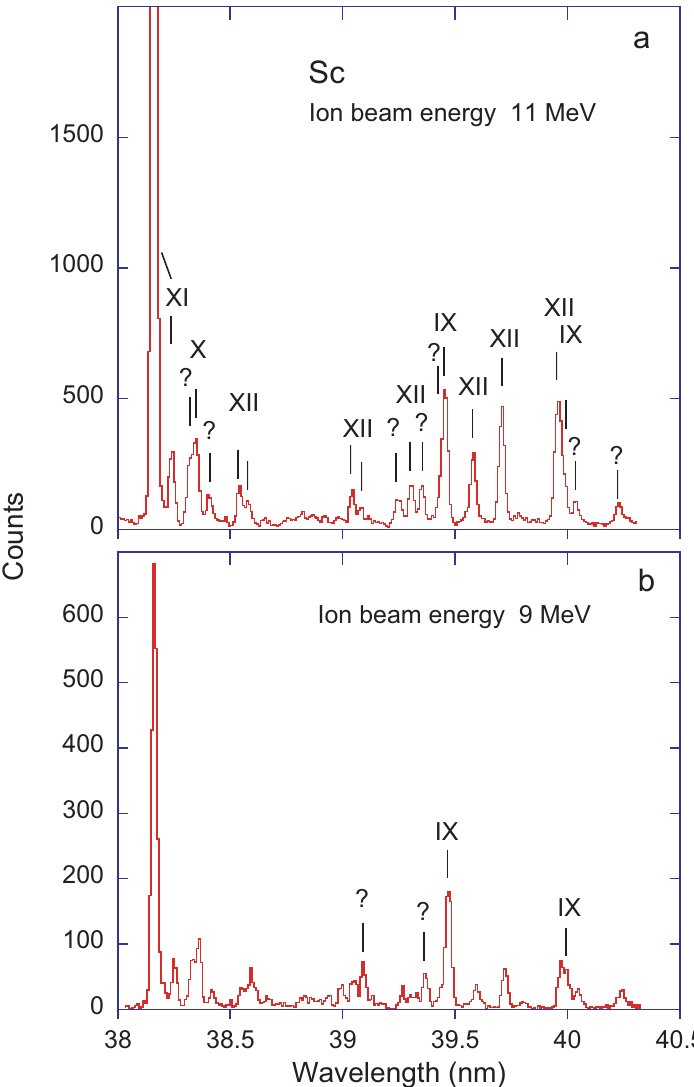
Figure 3. Beam-foil spectra of Sc at an ion beam energy of ( a ) 11MeV and ( b ) 9 MeV. Observation at the foil. Line width (FWHM) 0.03nm. The strongest lines in the upper spectrum are identified by the spectrum number. The lower spectrum indicates the higher yield of ScIX at the lower ion beam energy, while the contributions of ScXII are much weaker. The primary wavelength reference line at λ ≈ 38.1577nm is one of the prominent ScXI 3p–3d transitions which is boosted by yrast cascades. The lines in the wavelength interval 27.3 nm to 28.1 nm have not been identified